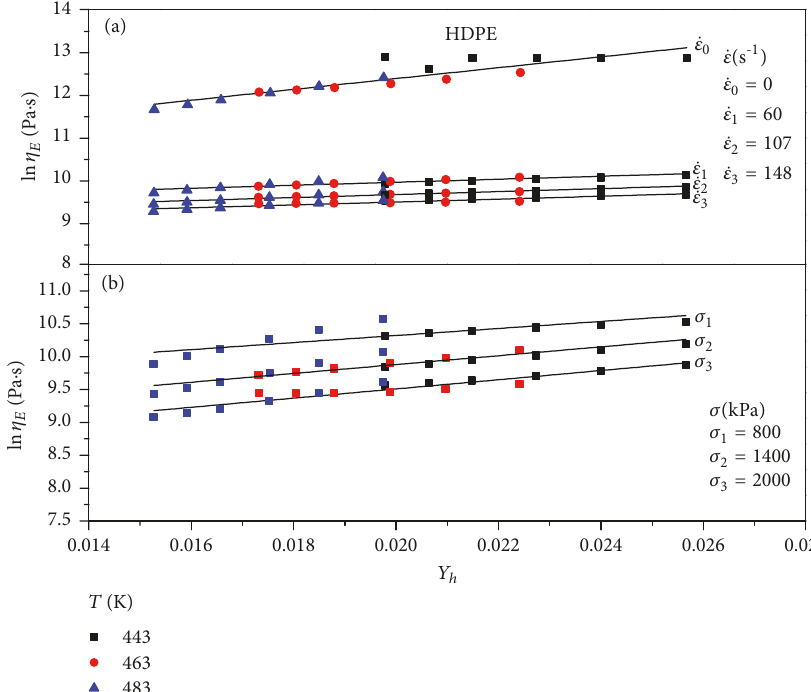
Figure 4: The logarithm of viscosities versus thermooccupancy function 𝑌 ℎ for HDPE (a) at the zero level of elongational and the constant elongational rates ( ̇𝜀 𝑐 =60, 107, and 148 s - 1 ), and (b) constant elongational stresses ( 𝜎 𝑐 = 800, 1400, and 2000kPa). Solid lines represent linear fitting through each data set by (7) and (8) with the parameters tabulated in Tables 2–4.